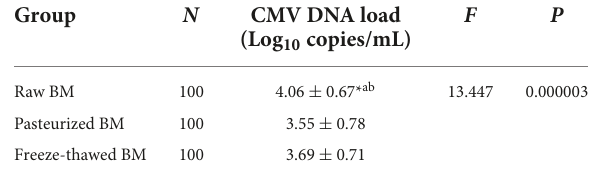
TABLE 3 Comparison of cytomegalovirus (CMV) DNA load before and after breast milk